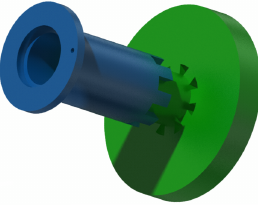
Figure 6. The lever arm (blue) is slid over the servomotor output attachments (green) and connects through pins and holes of a particular shape.